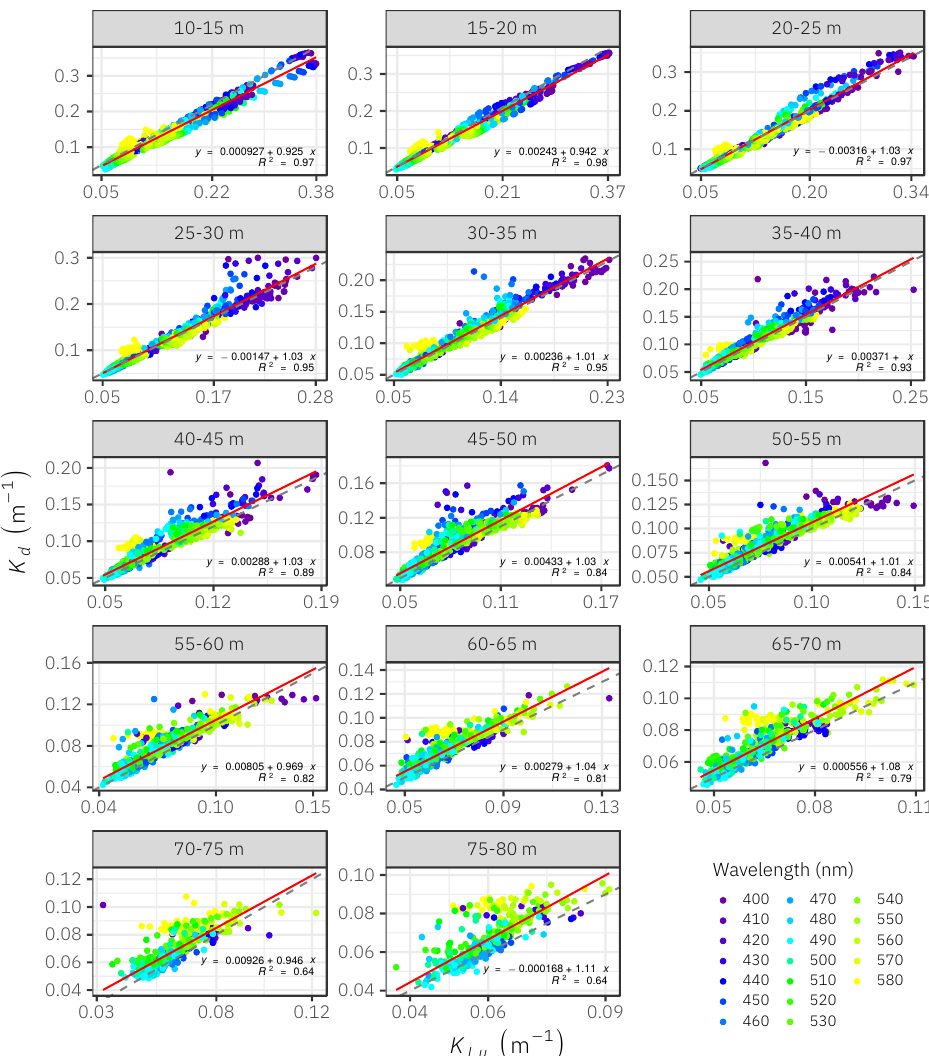
Figure 5. Scatter plots showing the relationships between the measured K d and K Lu in the spectral range between 400 and 580 nm at different depths (numbers in gray boxes). Red lines represent the regression lines of the fitted linear models. Regression equations and determination coefficients ( R 2 ) are also provided in each plot. Dashed lines are the 1:1 lines.